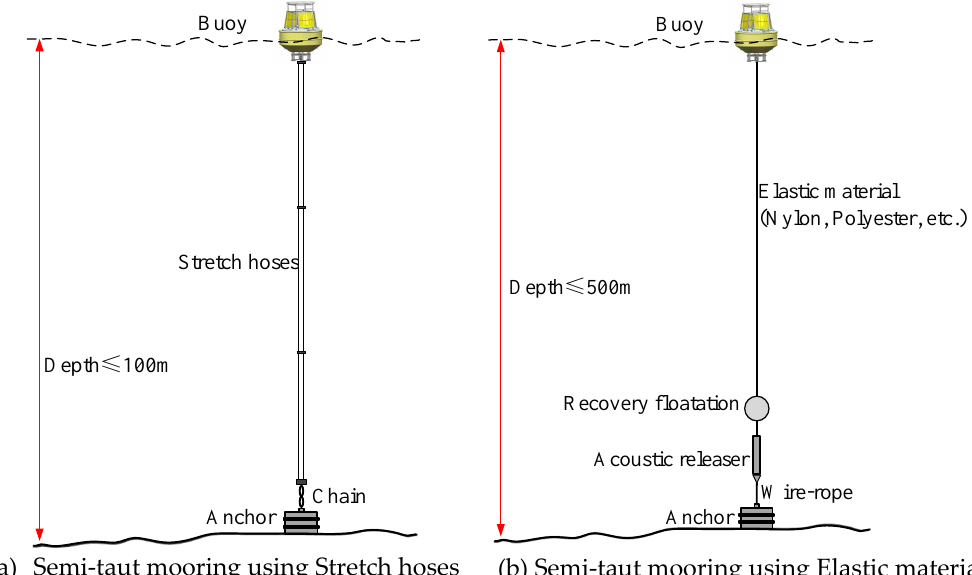
Figure 2. Semi-taut mooring.